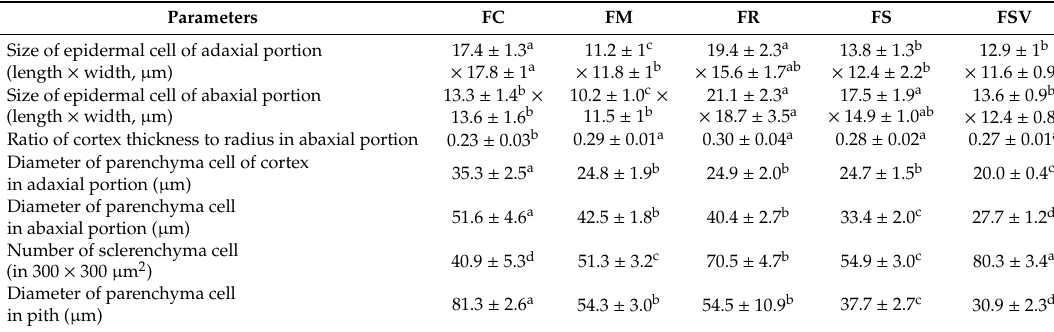
Table 2. Anatomical characteristics of the petiole of Fraxinus